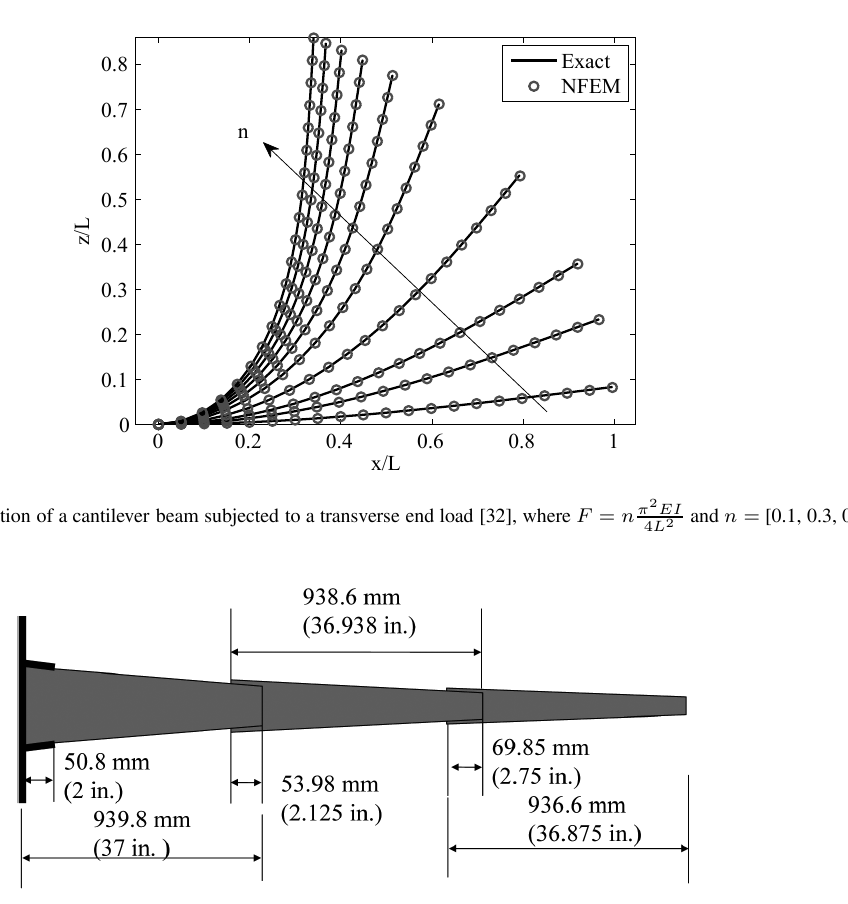
Fig. 6. Experimental 3 piece assembled fl y